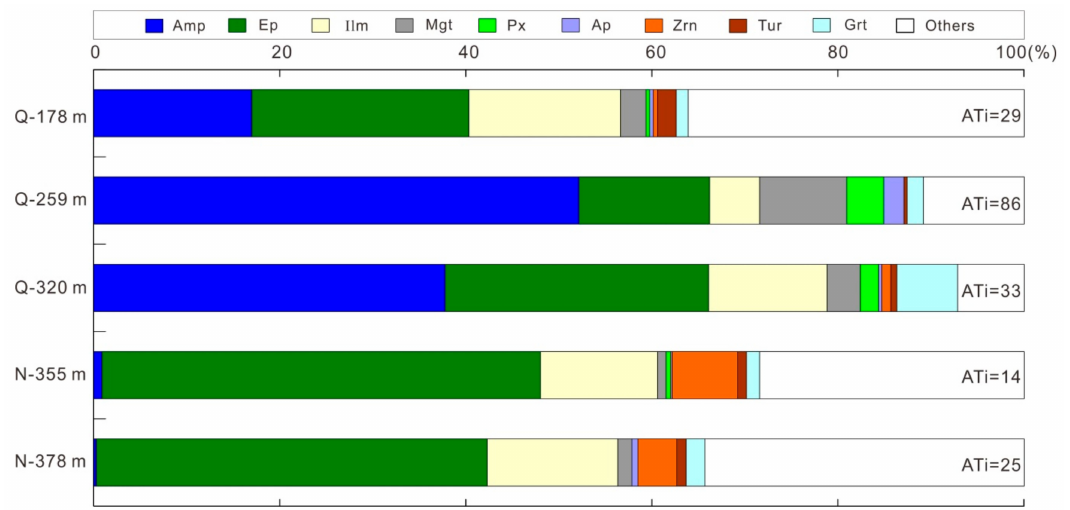
Figure 12. Heavy mineral distribution for Core LQ24 of the Changjiang Delta. Heavy mineral data are from [3]. The analyzed size fraction is very fine sand (63–125 µ m). N = Pliocene, Q =